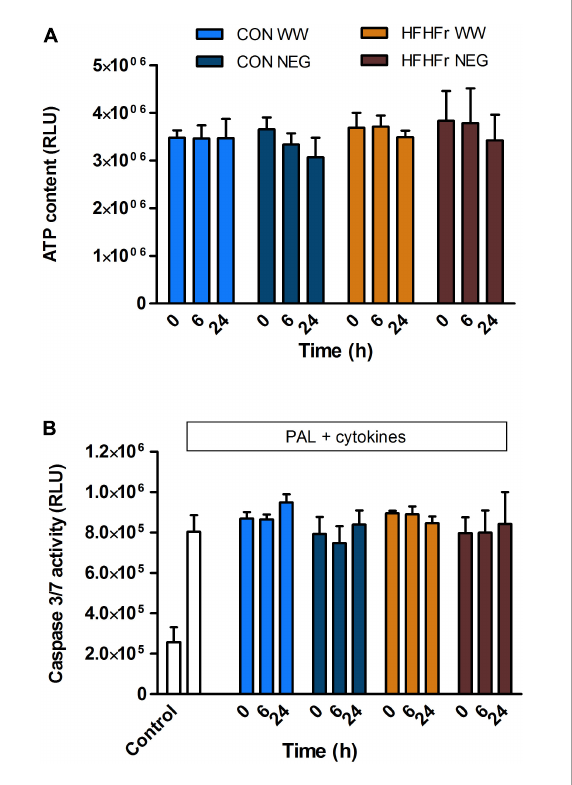
FIGURE6 Effect of phenolic acid-rich wholegrain wheat (WW) or negative control (NEG) fermentation supernatants on MIN6 beta cell viability (A) and apoptosis (B) . (A) Cells were exposed for 20 h to 1% (v/v) fermentation supernatants collected after 0, 6, or 24 h of fermentation of 1% (w/v) wholegrain wheat substrate in 1% (v/v) fecal slurry from control (CON) or HFHFr animals under normal tissue culture conditions for assessment of viability. (B) Apoptosis was measured following exposure to a combination of 250 µ M palmitate (PAL) and 25 U/ml IL1 β + 500 U/ml TNF α (Cyto) with or without fermentation supernatants. Data are expressed as mean ± SEM of three independent experiments. (A) P > 0.05 NEG vs. WW, P > 0.05 CON vs. HFHFr at each time point. (B) P > 0.05 fermentation supernatants + PAL/Cyto vs. PAL/Cyto only, P > 0.05 CON vs. HFHFr at each time point (one-way